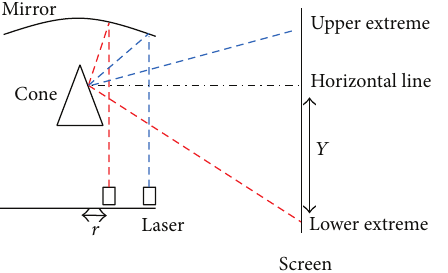
Figure 3: Experimental set-up to measure the angle of vertical emission.